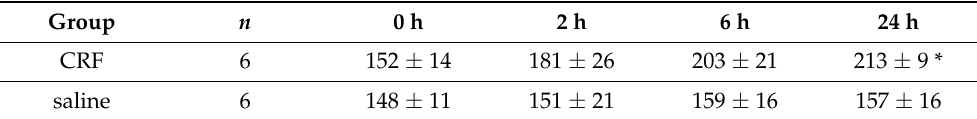
Table 2. The changes of serum TG levels in each time points in